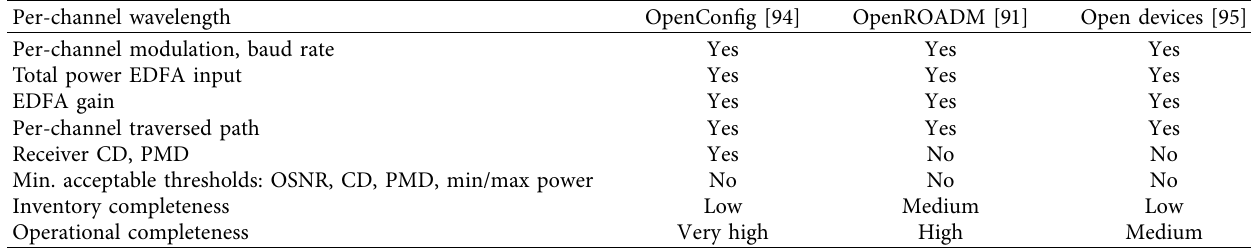
Table 7: Gap analysis on physical layer parameters of interest for QoT